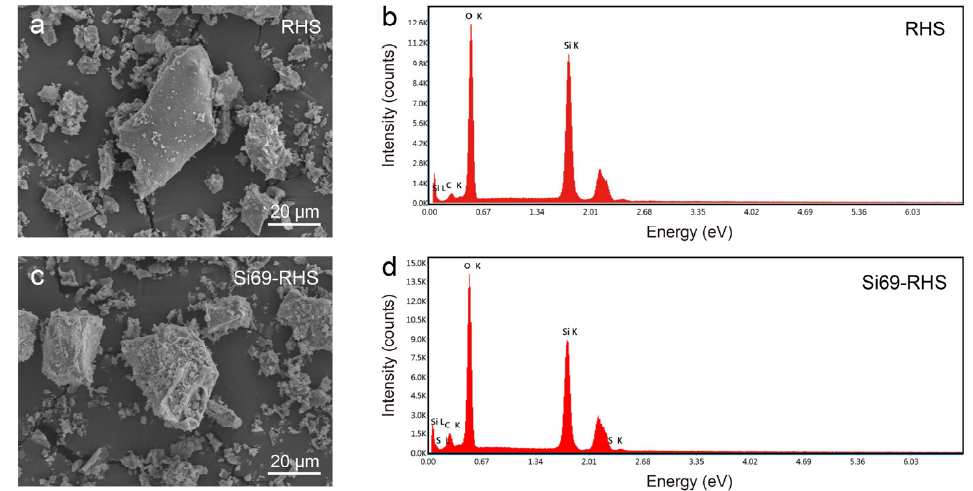
Figure 3. SEM images and the corresponding EDS spectra of RHS ( a , b ) and Si69-RHS ( c , d ). Note: The peak at 2.12 keV corresponds to the Au K signal from the sputtered gold films.